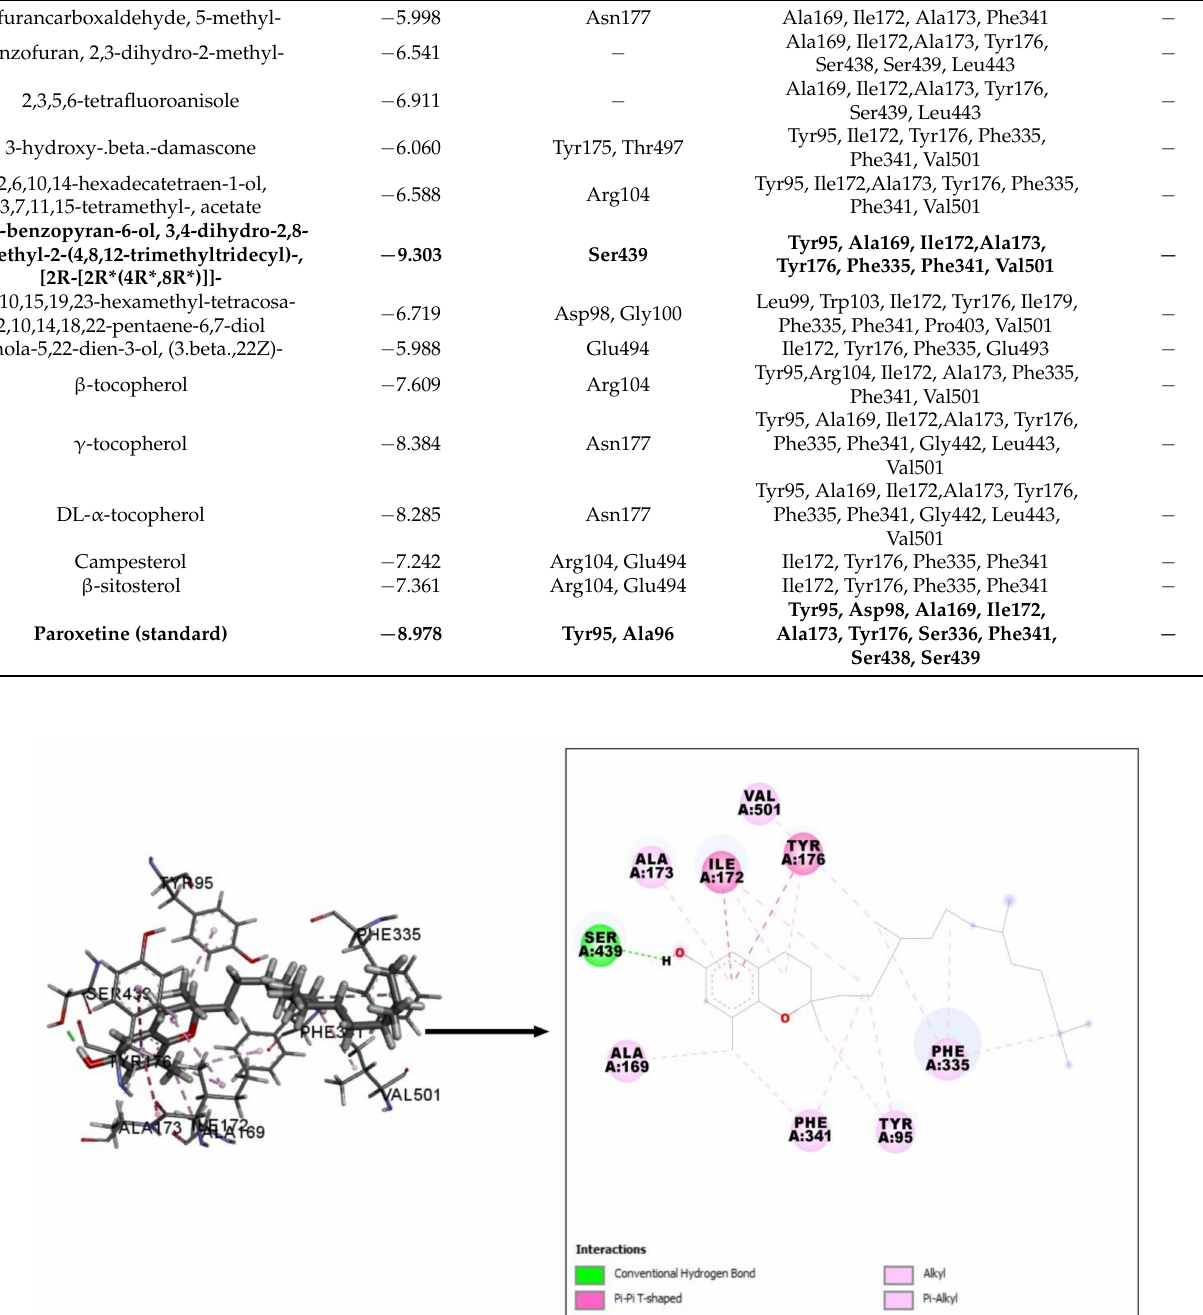
Attractive Charges